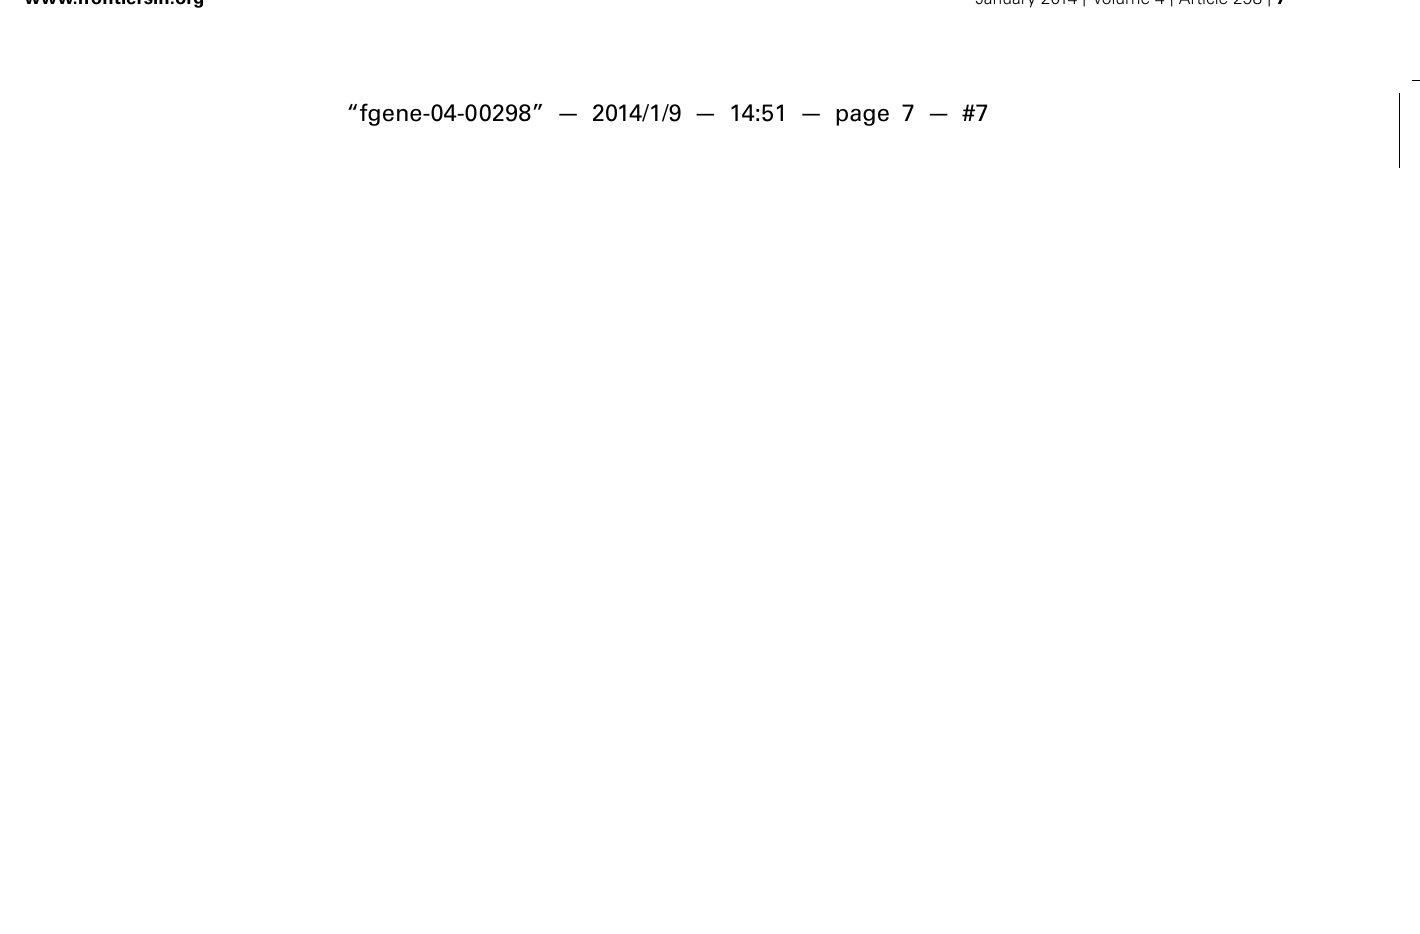
chemotherapy showing small signal response ( middle ) and after four cycles of chemotherapy demonstrating a striking change in tumor characteristics in response to therapy ( right ). Adapted from Jiang andWeatherall (2013), reproduced with